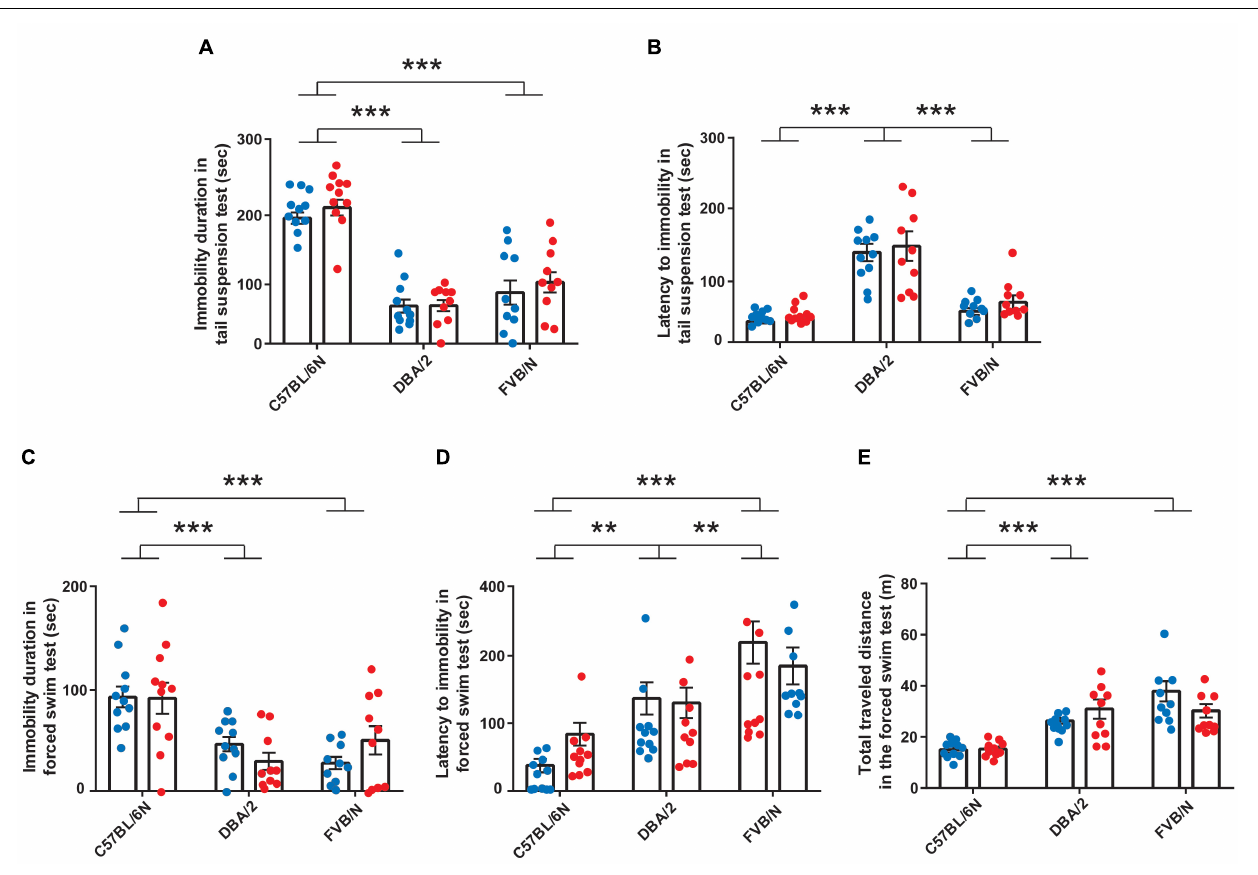
FIGURE 1 | Baseline despair-like behaviors in adult C57BL/6N, DBA/2, and FVB/N mice. (A) In the tail suspension test, adult C57BL/6N mice exhibited a higher duration of baseline immobility than DBA/2 and FVB/N mice. (B) Adult DBA/2 mice showed a significantly increased latency to first immobility compared to C57BL/6N and FVB/N mice. In the forced swim test, adult C57BL/6N mice showed a higher immobility duration (C) , a lower latency to first immobility (D) and a lower total traveled distance (E) than DBA/2 and FVB/N mice. In panels (A–E) , male and female mice within the aforementioned strains showed similar performance in the tail suspension and forced swim tests. Blue and red dots represent males and females, respectively. Two-way ANOVA was used followed by the Tukey’s post-hoc test for multiple comparisons to determine differences between the three strains, C57BL/6N, DBA/2, and FVB/N (** p ≤ 0.01, *** p ≤ 0.001) and Bonferroni correction to check differences between males and females within each strain. Error bars indicate the standard error of the mean